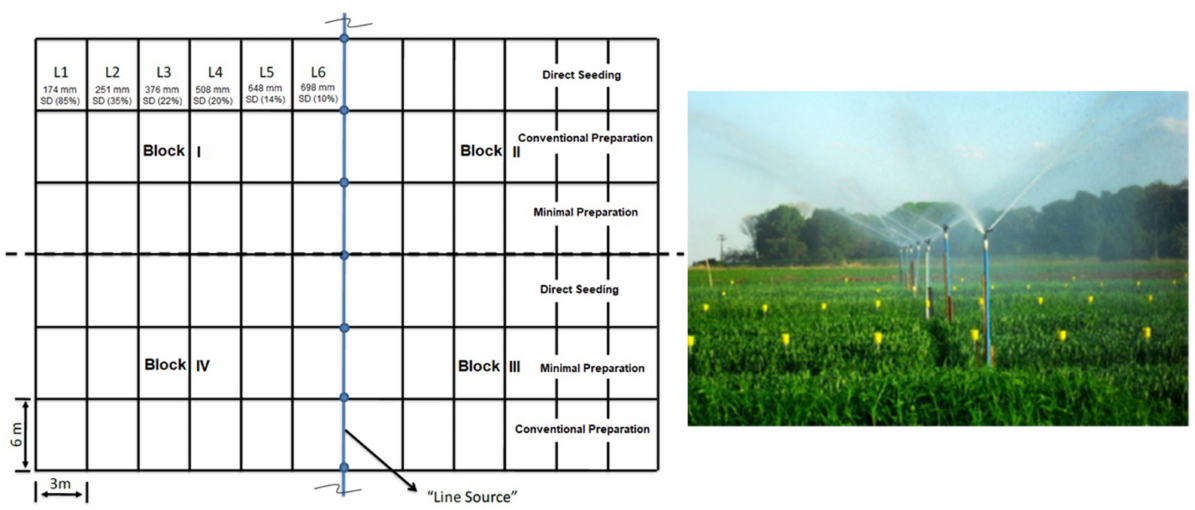
Figure 2. Experimental design field map and irrigation for cultivation of wheat in 2011 and 2012 in Tangar á da Serra, Mato Grosso state, Brazil. Photo: Thales A.D. Daniel,